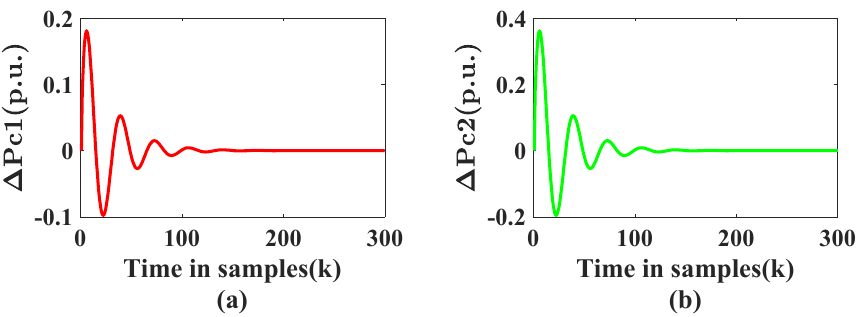
Figure 6. Output power deviation signal ∆𝑃 (cid:3032) of wind turbines under the PSO-MPC strategy with wind turbines. ( a ) Output power deviation under Δ P L 1 ; ( b ) Output power deviation under Δ P L 2 .